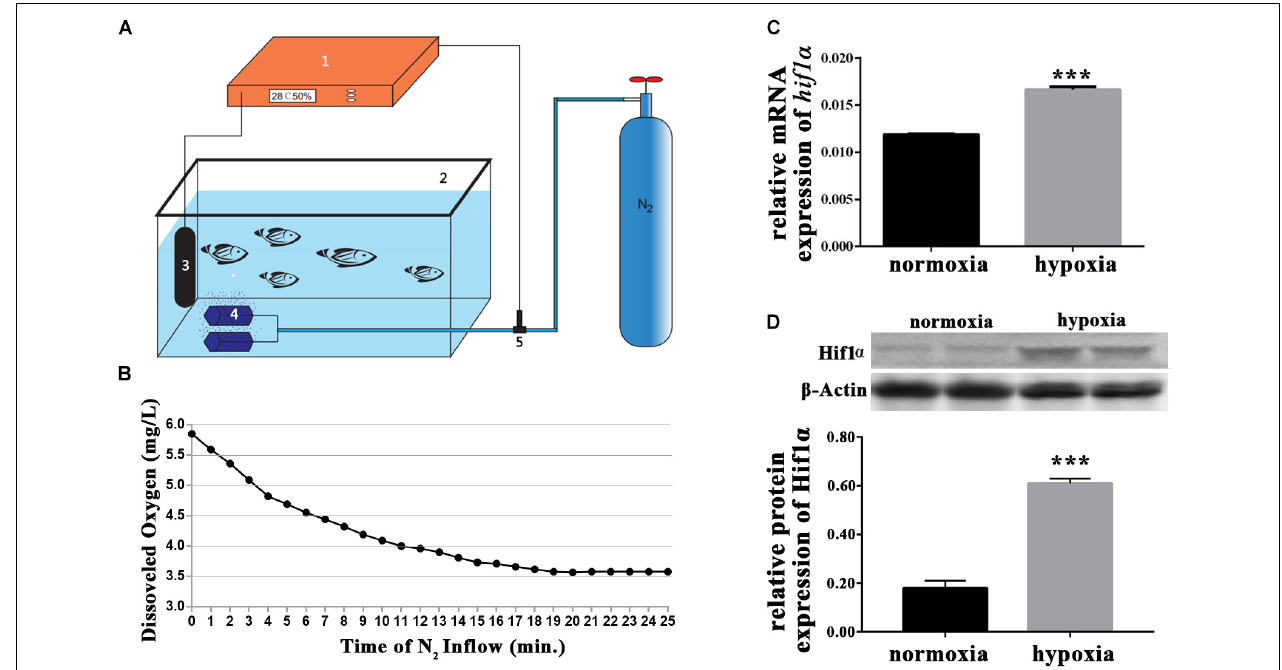
FIGURE 1 | Hypoxic setup for larval zebrafish. (A) (1) oxygen regulator; (2) hypoxic larval aquarium; (3) oxygen electrode; (4) air stone; and (5) solenoid valve. The compressed nitrogen source is shown as a blue gas cylinder. (B) Dissolved oxygen in the hypoxic aquarium decreased slowly over time as nitrogen perfusion increased until dissolved oxygen stabilized at 3.5 mg/L. (C) qRT-PCR analysis showing that hif1 α mRNA expression was significantly increased under hypoxia. (D) Western blot of Hif1 α protein expression showing that hypoxia enhanced Mbp protein translation. ∗ P < 0.05; ∗∗ P < 0.01; ∗∗∗ P <